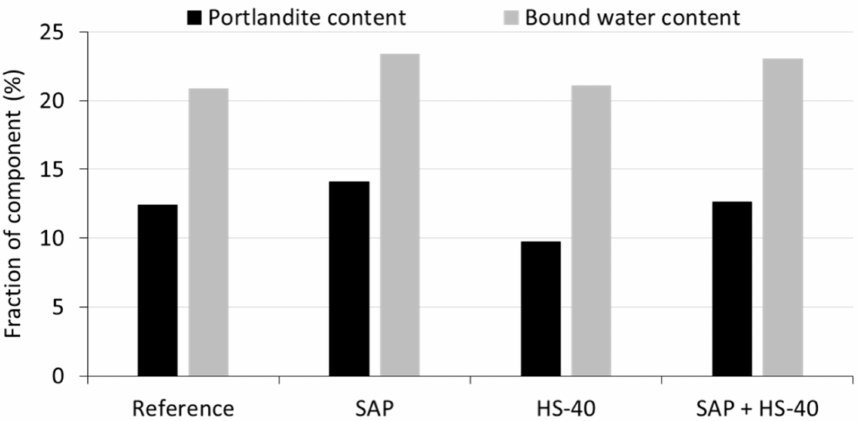
Figure 9. Portlandite and bound water content of cement pastes after 90 days of